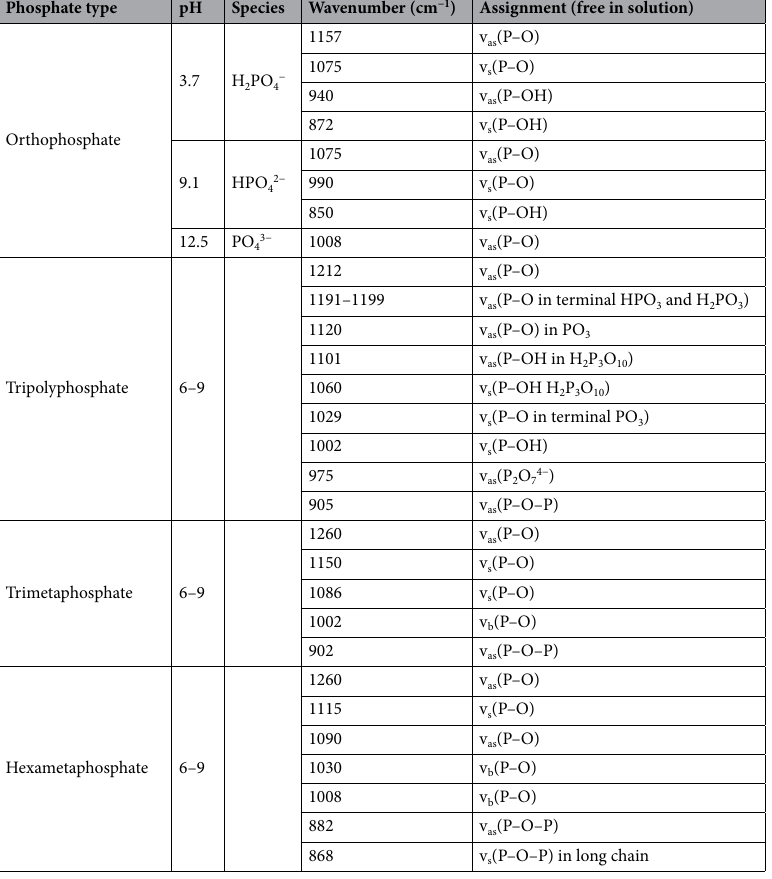
Table 1. Assignment of ATR-FTIR peaks for phosphates in solution based on Guan et al. 32 , Lu et al. 33 , Michelmore et al. 31 , Socrates 34 , and Wan et al. 35 . v as —asymmetric stretching vibration, v s